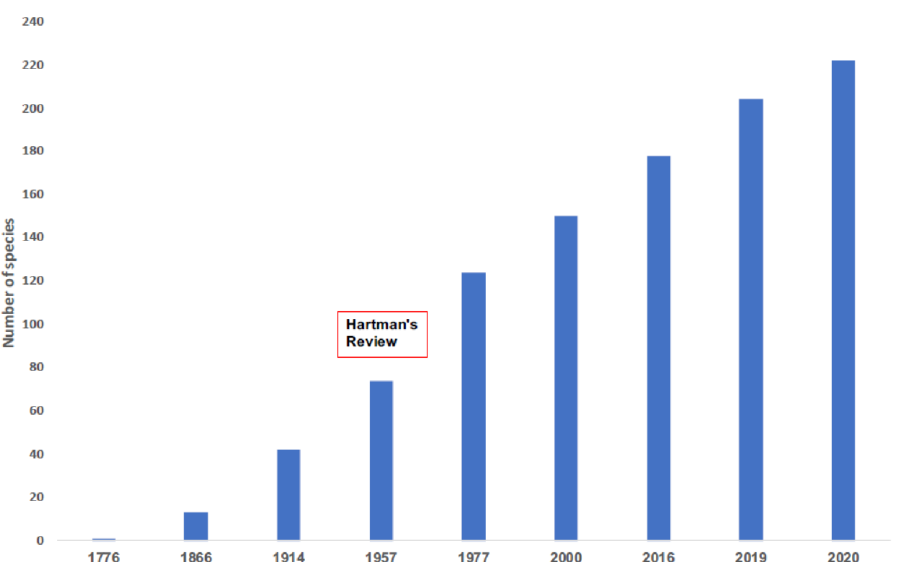
Figure 9. Bar diagram showing the evolution of the number of known orbiniid species from the first described species, Scoloplos armiger , in Müller [123] to this study. Note the exponential growth in species discoveries after Eisig [93] and, specially, during the subsequent decades to the Hartman’s review